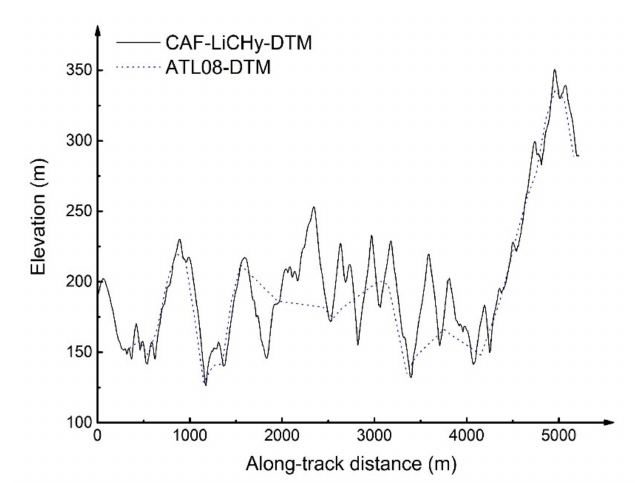
Figure 8. DTM established by ATL08 and